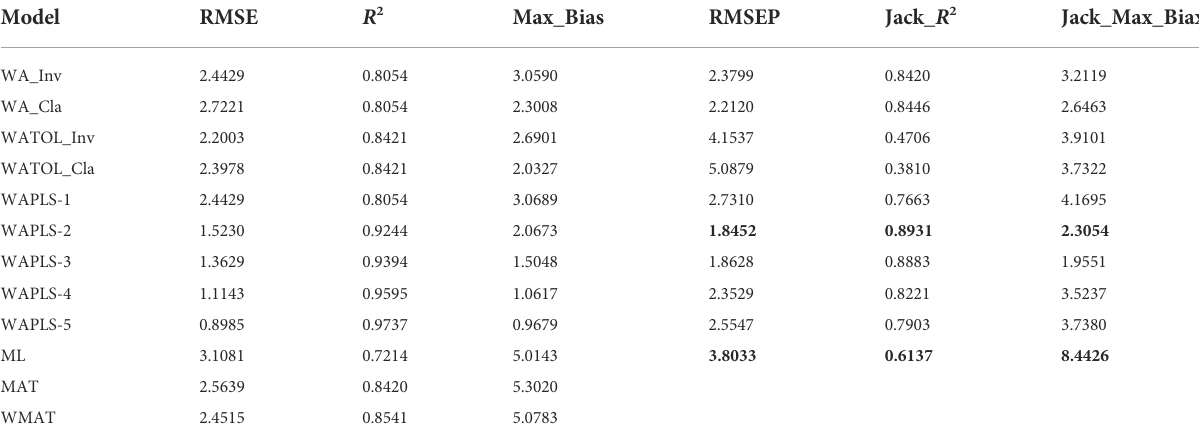
TABLE3Statisticalperformanceoftheweightedaveragingpartialleastsquares(WAPLS)modelcomparedwithothermodelsfordiatom-waterdepth transfer function from Lake Kalakuli.